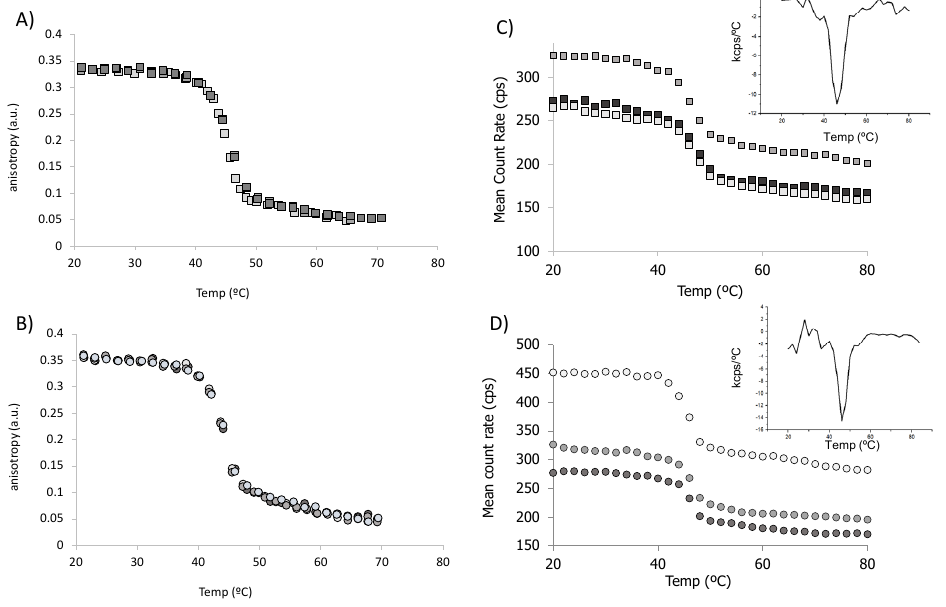
Figure 2. Characterisation of phase transition temperature of PC ( A , C ) and PC/PE ( B , D ) liposomes by steady-state fluorescence spectroscopy ( A , B ) and by dynamic light scattering ( C , D ). Graphs show DPH anisotropy plot as a function of temperature ( A , B )and mean count rate plot as a function of temperature ( C , D ). Insets in Figures C and D show the first-derivative plots of mean count rate/ ° C across the temperature range. Measurements correspond to independent experiments (n = 3).